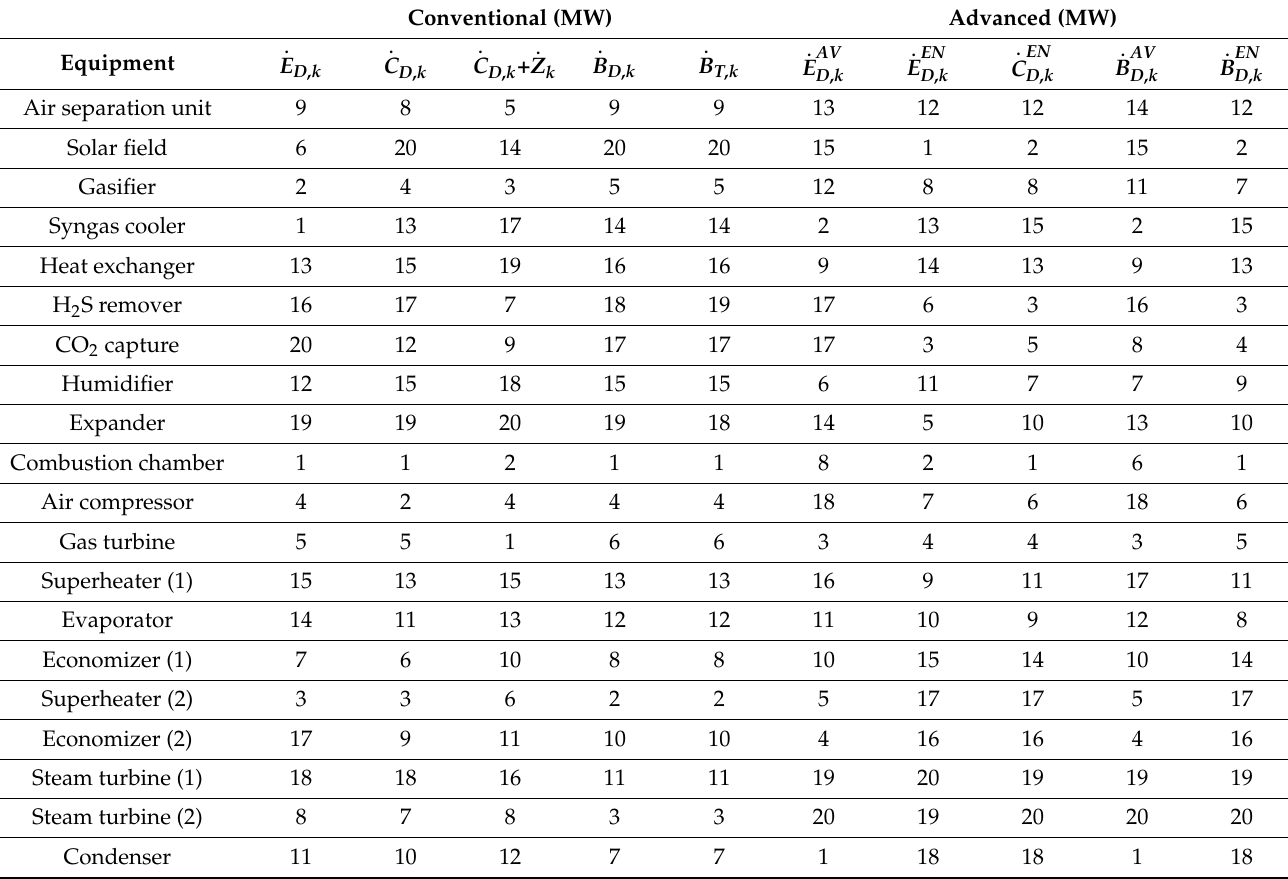
Table 7. Ranking of equipment obtained from conventional and advanced exergy